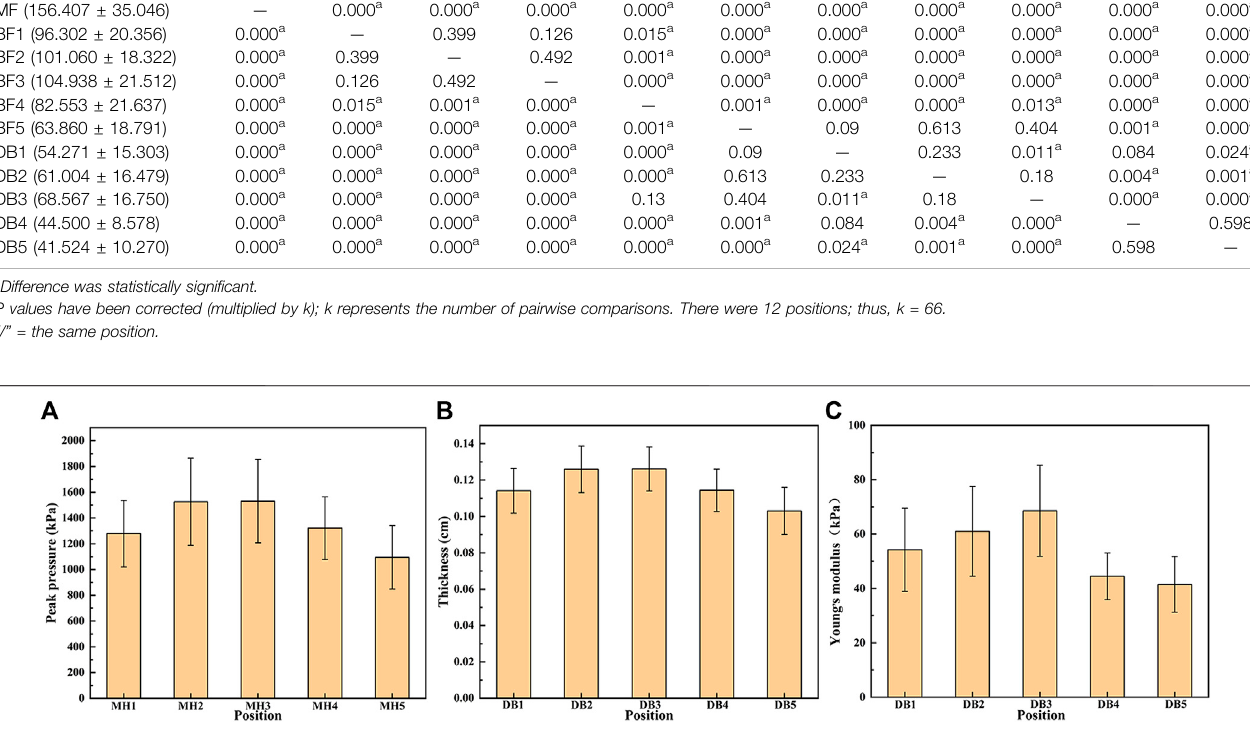
Frontiers in Bioengineering and Biotechnology |